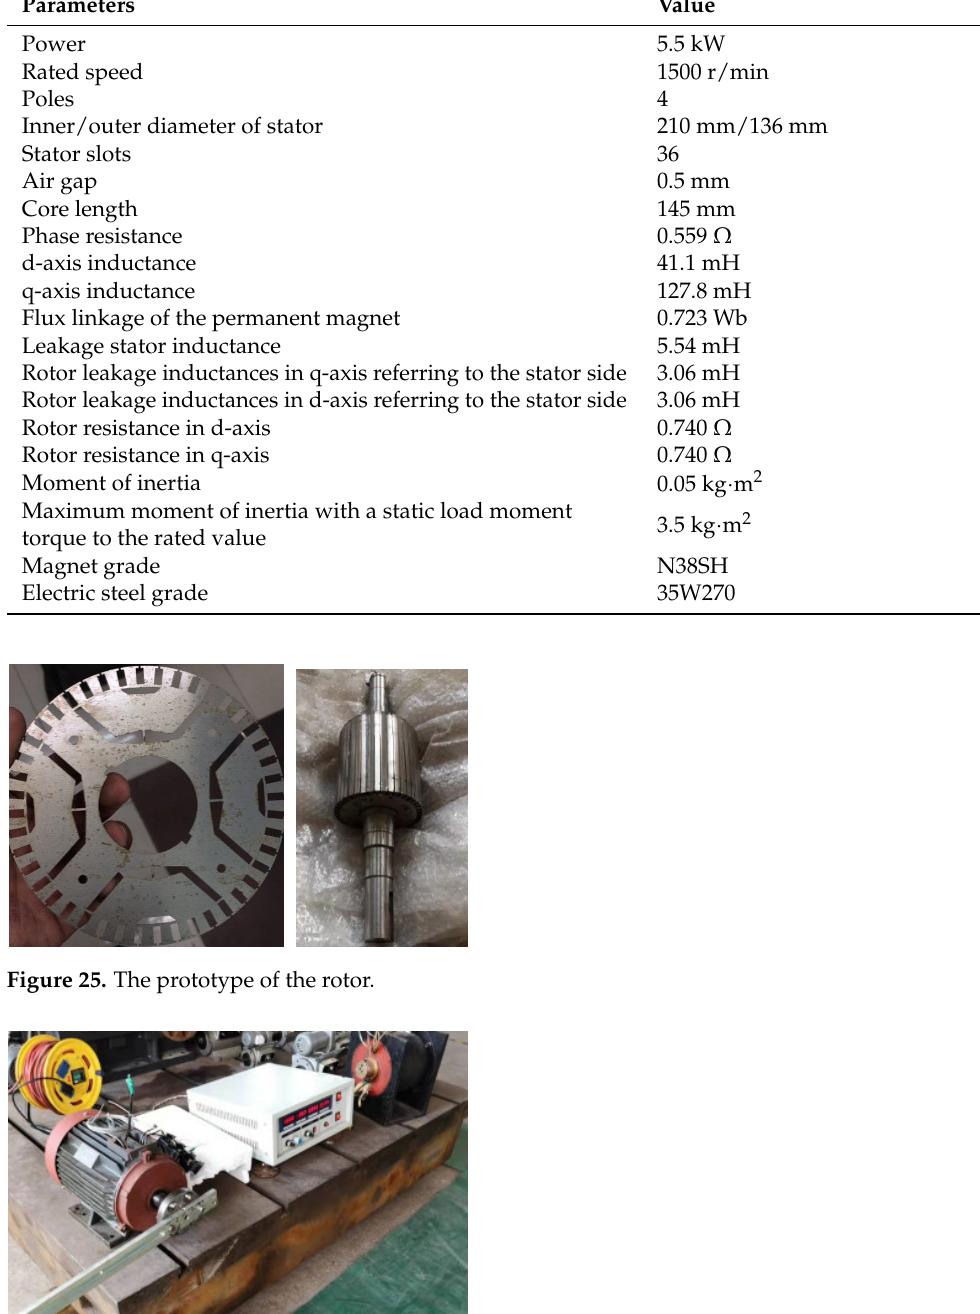
Figure 27. The load test of the prototype. Figure 28. The power factor curve ( U = 174.3 V).